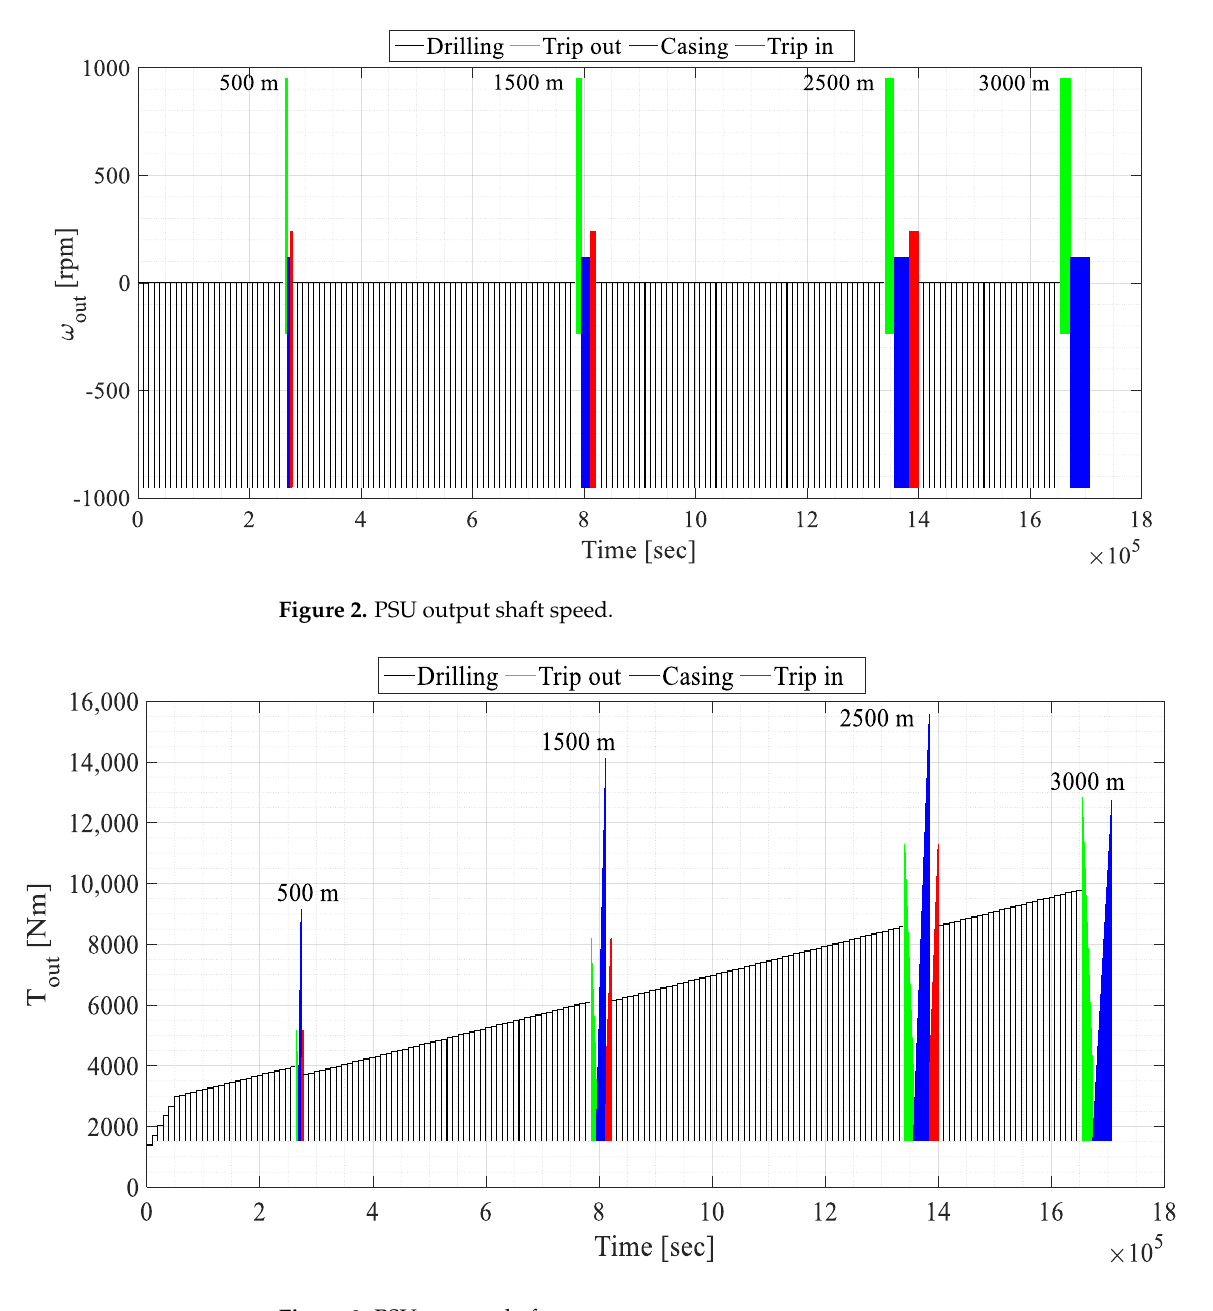
Figure 3. PSU output shaft torque.